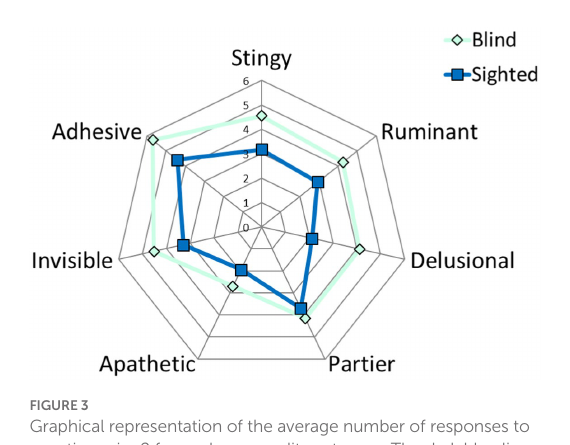
FIGURE 3 Graphical representation of the average number of responses to questionnaire 2 for each personality category. The dark blue line represents sighted participants; the light blue line represents blind